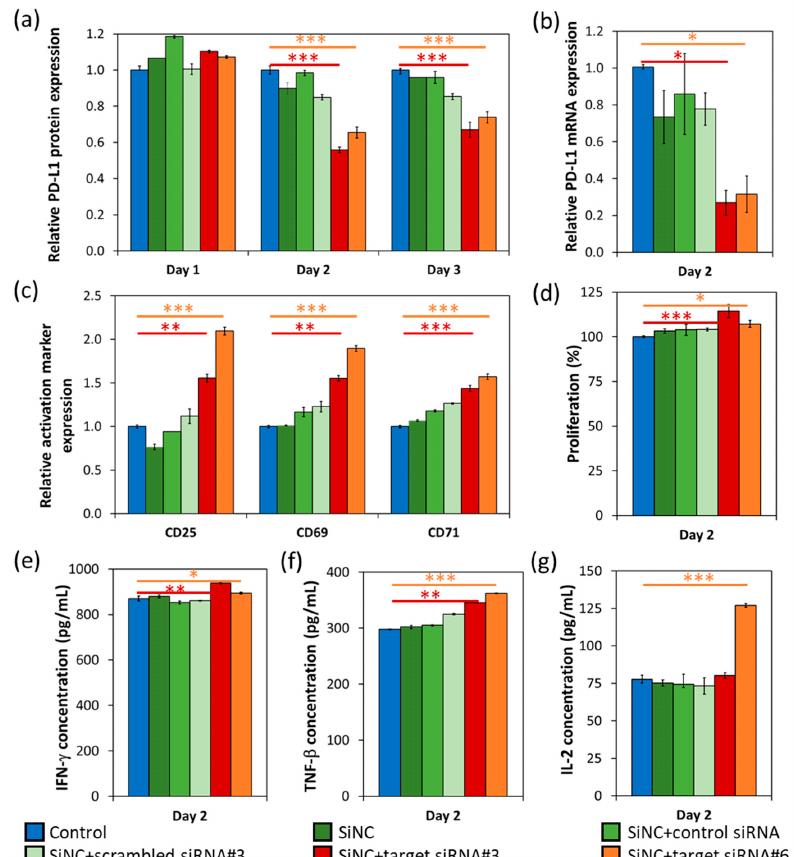
Figure 4. The PD-L1 knockdown e ffi ciency at the protein level was determined from the relative PD-L1 protein expression profiles that were observed from day 1 to day 3, by flow cytometry analysis (Figure 4a). A decrease in PD-L1 protein production of T-cells treated with SiNC + target siRNA#3 and #6 compared to cell control was observed since day 2, with a knockdown e ffi ciency of 44% and 35%; and an e ffi ciency of 33% and 26% on day 3, respectively. Corresponding to the reduction of mRNA production analyzed by quantitative PCR (Figure 4b), the PD-L1 mRNA expression of T-cells treated with SiNC + target siRNA#3 and #6 dropped dramatically, when compared to the cell control with a knockdown e ffi ciency at an mRNA level of 73% and 68% on day 2, respectively. The observation that the knockdown e ffi ciency at mRNA level was higher than that at the protein level was quite common and these results were also found in other reports [19,20]. As the siRNA binds directly to the specific mRNA, it results in the degradation of the corresponding mRNA. Whereas the protein level not only depends on the mRNA synthesis, but also on the protein-half life and the translational steps [19]. The other controls (SiNC, SiNC + control siRNA, and SiNC + scrambled siRNA#3) all showed a slight reduction of the PD-L1 protein and the mRNA expression, compared to the cell control. This reduction is resulted from a non-specific reaction of those SiNCs to the cells. Cells 2020 , 9 , x FOR PEER REVIEW